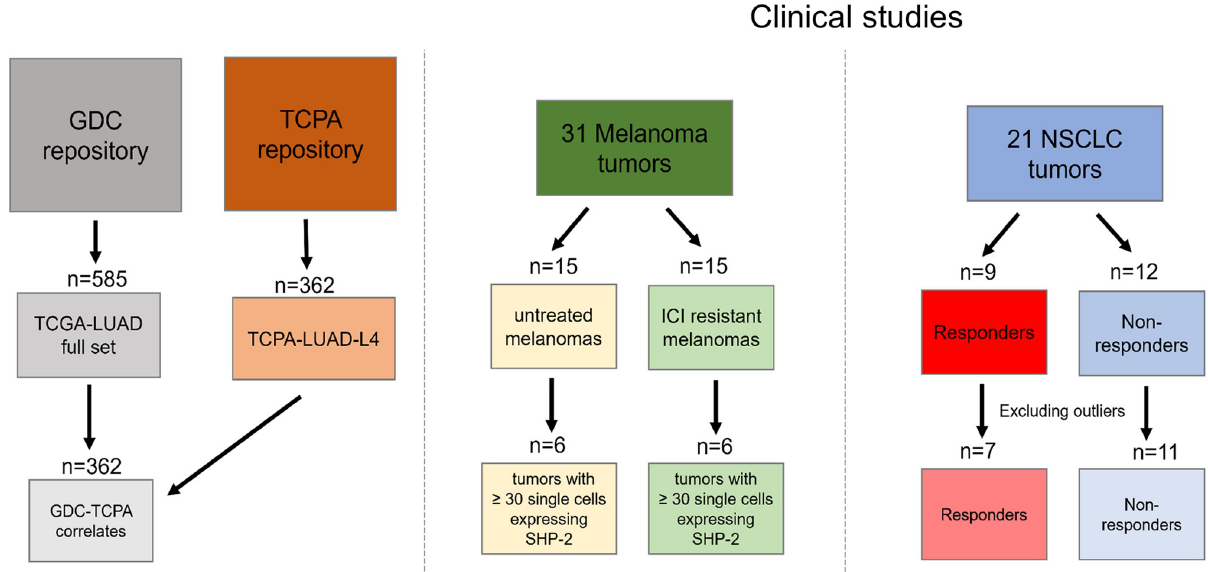
Fig 2. Workflow scheme for evaluation of SHP2 and PD-L1 relationships. Reverse-phase protein array (RPPA) was collected from the TCPA data repository (https://gdc.cancer.gov/about-data/publications/pancanatlas) for 362 total patients labeled as the TCPA-LUAD-L4 data set. RNAseq data was collected from GDC for the full TCGA-LUAD dataset (n = 585). These data were parsed to include only patients for which there was matching RPPA data on TCPA (n = 362). Single-cell RNAseq reads for 31 melanoma tumors were collected and separated into two groups based on ICI treatment status. Only single-cell reads for ‘malignant melanoma cells’ were retained for analysis. Tumors which had � 30 unique malignant cells with non-zero PTPN11 values were included in the analysis. NSCLC tumors (n = 21) with sequence data were first separated into two groups based on response to ICI treatment. Average TPM values were calculated for PTPN11 and CD274, and tumors that had PTPN11 TPM value > 2 standard deviations from the mean were excluded from the analysis.